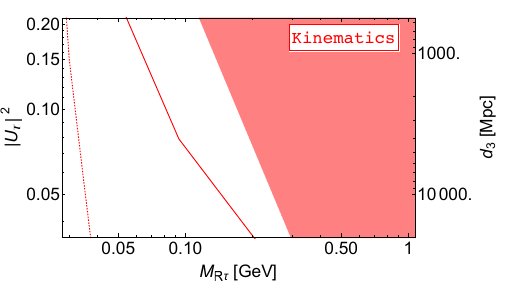
Figure 4. The viable region for τ -neutrino portal interaction. The mean free path of the heaviest neutrino with E ν = 1EeV is given in the right-hand side. We have taken M R τ > m φ 15 MeV and ˜ y τ = 4 π . The colored region might be excluded.